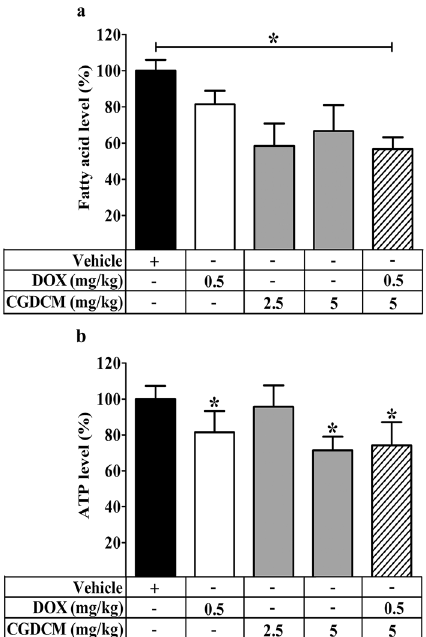
Figure 11. Combined effect of CGDCM extract from stem bark of C. gigantea on the production of fatty acid and ATP levels in DEN-induced liver cancer rats. DEN injection was performed for 8 weeks, and the treatments were performed for 4 weeks from week 12, which included DOX, CGDCM-L, CGDCM-H, and the combination of DOX with CGDCM-H. The vehicle group was treated with 0.8% DMSO. The percentages of ( a ) fatty acids and ( b ) ATP were measured in the liver tissue of rats at week 16. The data are reported as the mean ± SD (n = 3) and were analyzed using one-way ANOVA with Tukey’s HSD test, *p < 0.05 compared to week 0. CGDCM , C. gigantea dichloromethane extract; CGDCM-L, CGDCM low dose; CGDCM-H, CGDCM high dose; DOX,